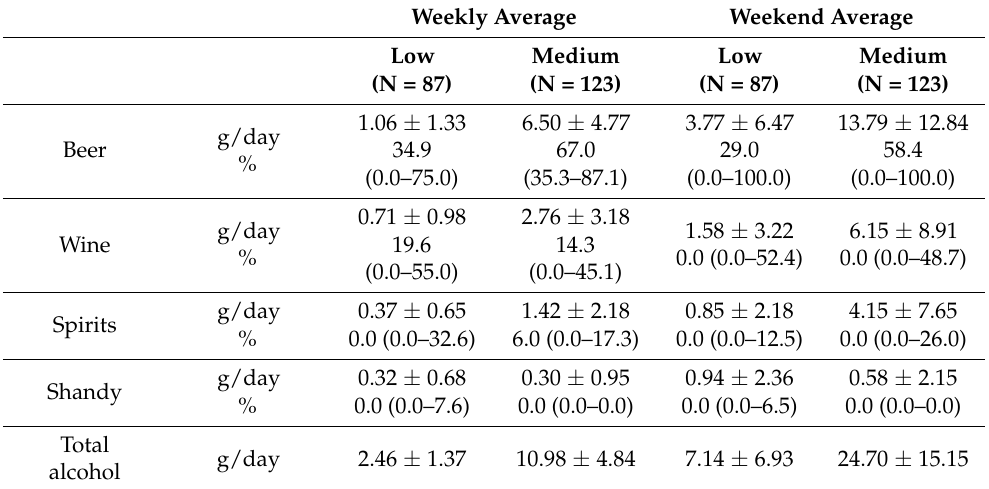
Table 2. Daily consumption of different alcoholic beverages on a weekly basis and on the